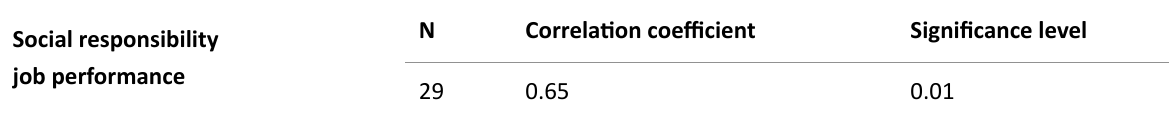
Table 3. Shows the Pearson correlation coefficient between the scales of social responsibility and job